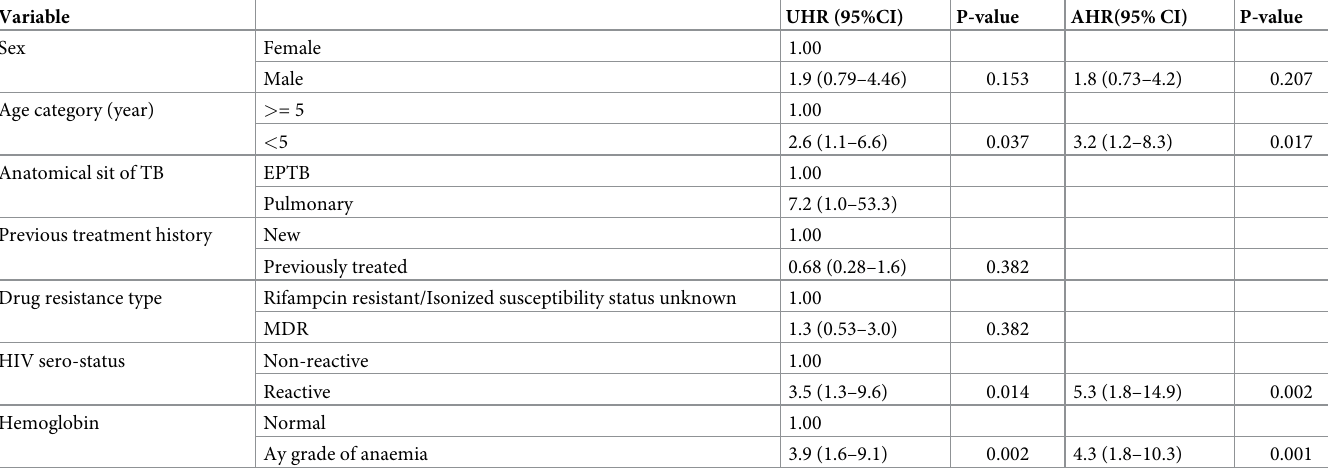
Table 3. Risk factors of death and treatment failure in children on DR-TB treatment in Ethiopia,